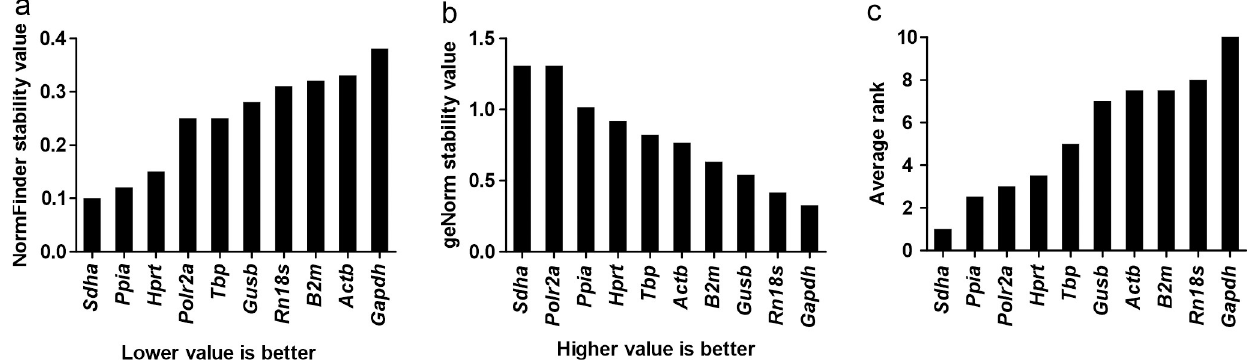
Fig 4. Comparison of the stability values of the candidate reference genes. Values from a) NormFinder and b) geNorm, and c) average of ranks based on the two programs.